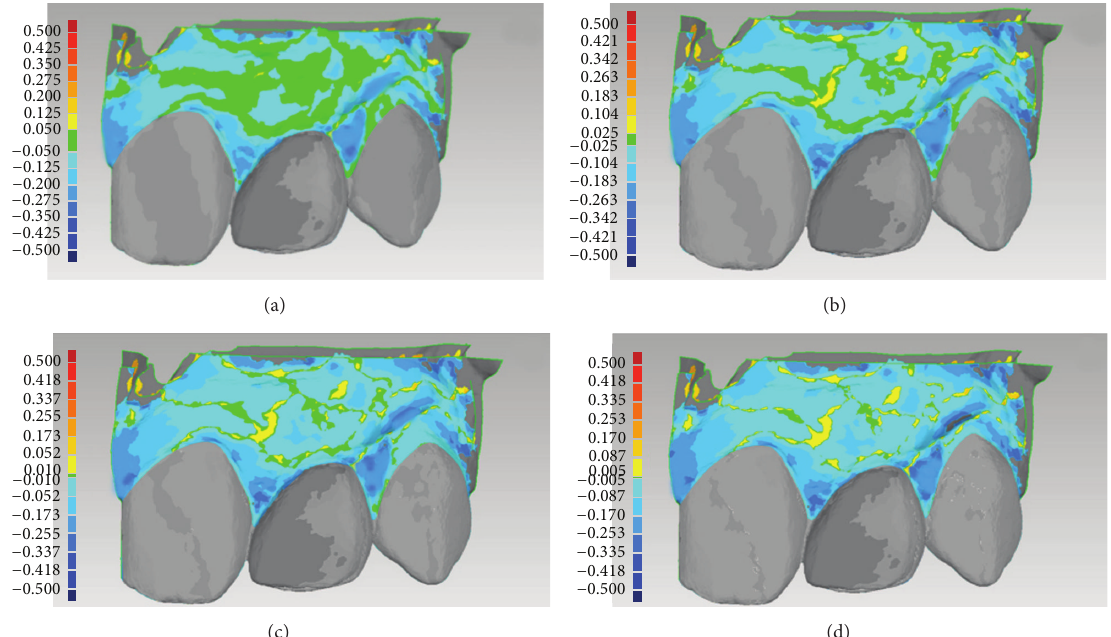
Figure4:Conventionalimplantplacementinhealedridge( control group)ofayoungfemalepatient(19yearsold)whounderwentorthodontic treatment: (a) overlapping of digital images (S2 over S1): colorimetric map, first setting (50 𝜇 m). The soft tissues overlying the